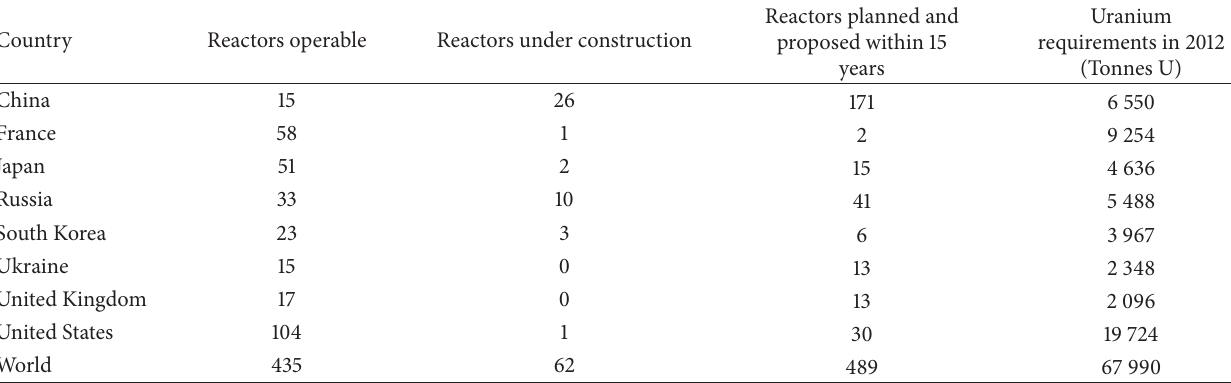
Table 2: The 8 biggest civilian nuclear powers: planned reactors and uranium requirements in 2012.